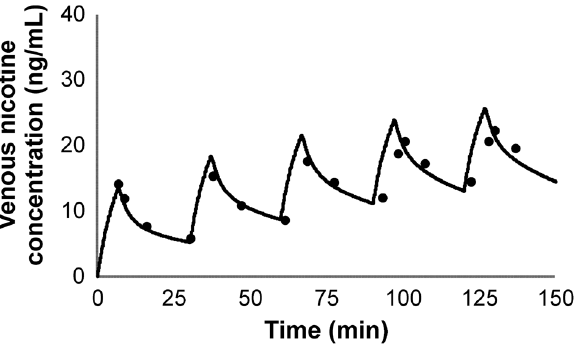
Figure 14. Simulation of the time-course kinetic data during and after repeated use of a conventional cigarette 29 . The subjects were allowed to smoke 1 cigarette every 30 min for a total of 7 cigarettes over the 7 h. Nicotine yield was reported as 0.81 ± 0.2 mg. Points represent data from the study and solid lines represent simulation results.